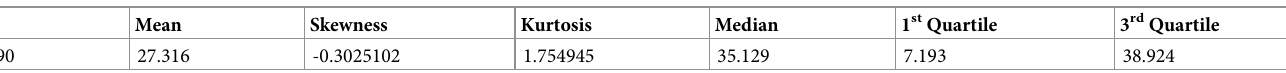
Table 6. Descriptive analysis.